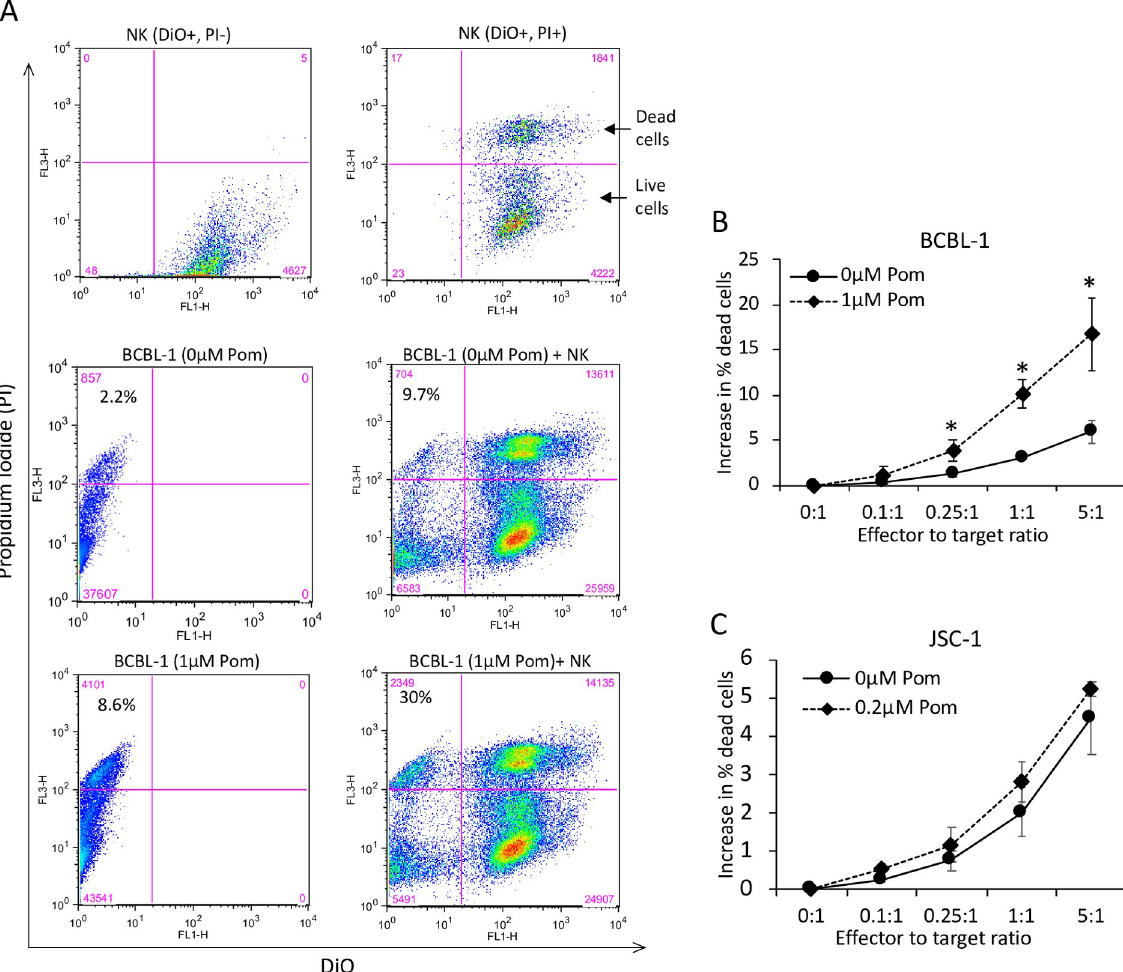
Fig 4. Pom increases NK-mediated cytotoxicity of BCBL-1 cells. BCBL-1 or JSC-1 cells grown for 48 hours in the presence of DMSO ctrl (0 μ M Pom) or indicated concentrations of Pom were coincubated with DiO-labelled YTS NK cell lines for 4 hours and then labelled with propidium iodide (PI) to determine NK-mediated cytotoxicity using flow cytometry. Note that YTS NK cells were never exposed to Pom in these experiments. (A) Representative FACS histograms showing the gating strategy. PI and DiO gates were established using DiO-positive NK cells (upper panel) with or without PI staining. Histograms for control (middle panel) or Pom-treated (lower panel) BCBL-1 cells with or without NK cells are also shown. The total number of cells within each quadrant and the percent of BCBL-1 cells that are dead (PI+ve, DiO-ve fraction) are indicated. (B and C) NK-mediated cytotoxicity of control or Pom-treated BCBL-1 (B) and JSC-1 (C) cells expressed as increase in % dead cells at various effector to target ratios. % dead cells in the absence of NK cells (0:1 effector to target ratio) was subtracted from %